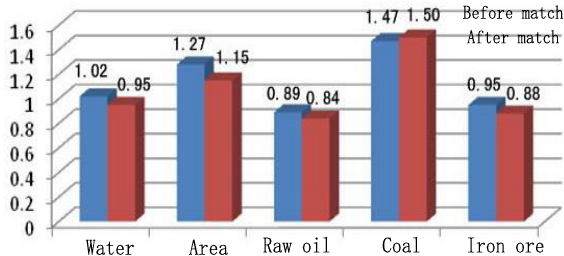
Figure 8. Comparison of vested benefits before and after the